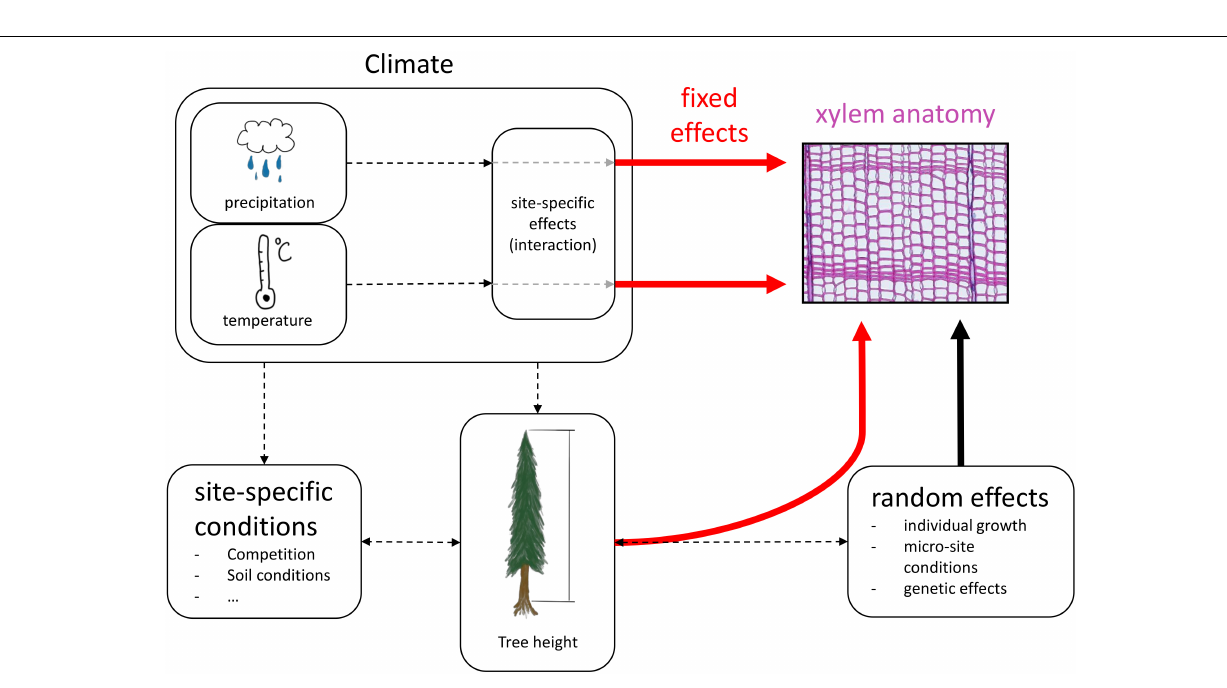
Frontiers in Plant Science |